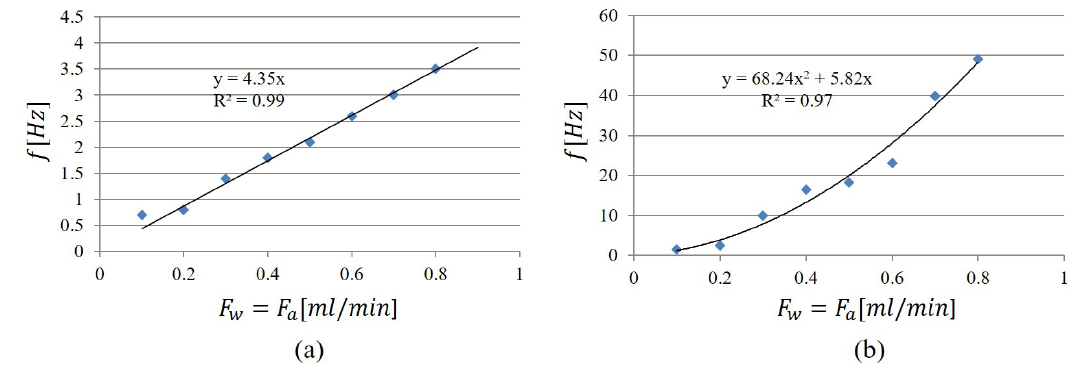
Figure 6. The values of slug frequency computed by the two peaks identified in the spectra versus the input flow rates for the eight experiments F ∈ { 0.1,0.2,0.3,0.4,0.5,0.6,0.7,0.8 } mL/min. ( a ) water frequency; ( b ) air frequency.